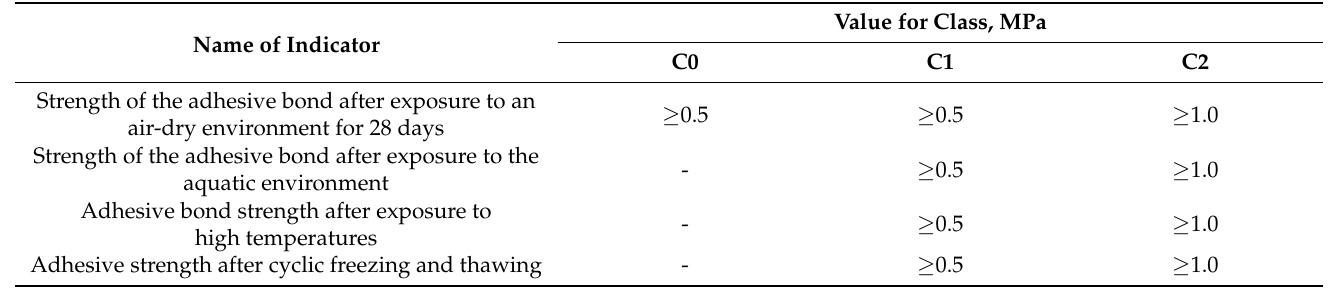
Table 1. Requirements for adhesive mixtures of various classes